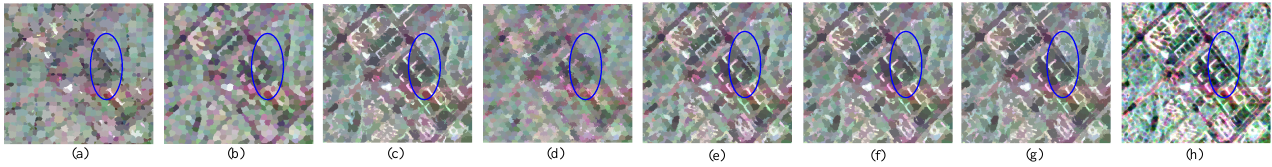
Figure 20. Enlarged results for region C of data set 5. ( a ) POL-SLIC. ( b ) POL-LSC. ( c ) POL-HLT. ( d ) HAGS. ( e ) HAWS. ( f ) HAHS. ( g ) The proposed HADS. ( h ) Pauli-RGB